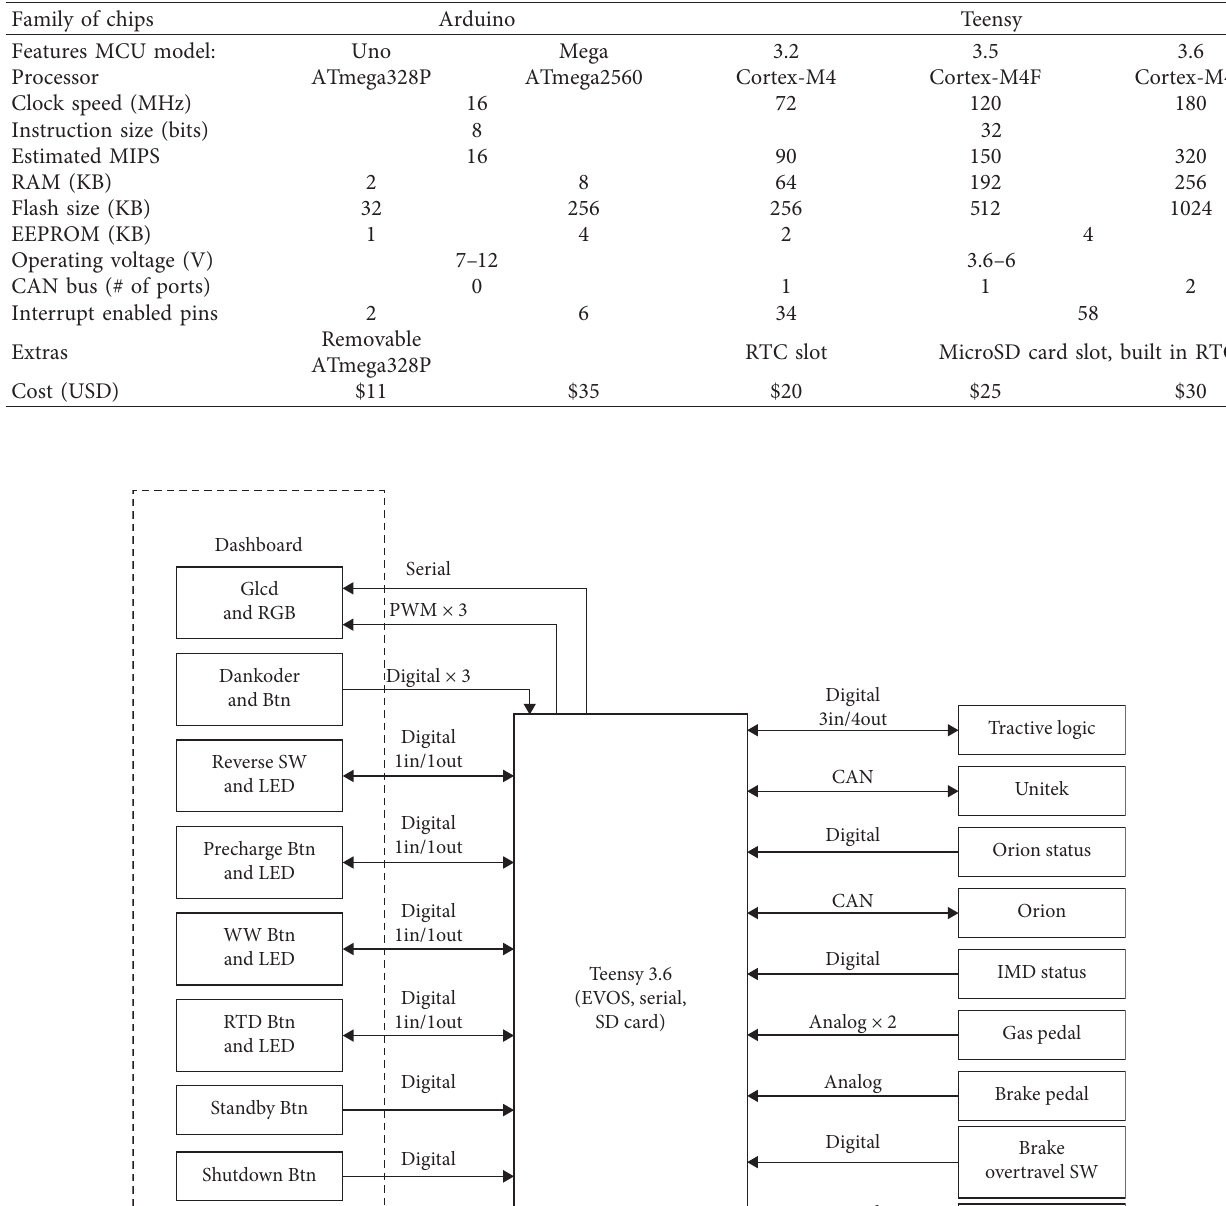
Table 3: Decision matrix of the microcontroller